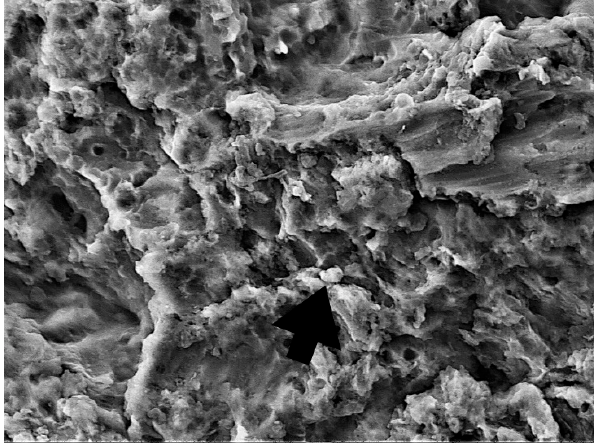
Figure 11. PDT2 group—bacterial and fungi reduction after 0.1% riboflavin and diode laser 445 nm treatment (3000 × ). Micro-organism cells can still be observed, but vitality of the cell cannot be discussed (arrow).